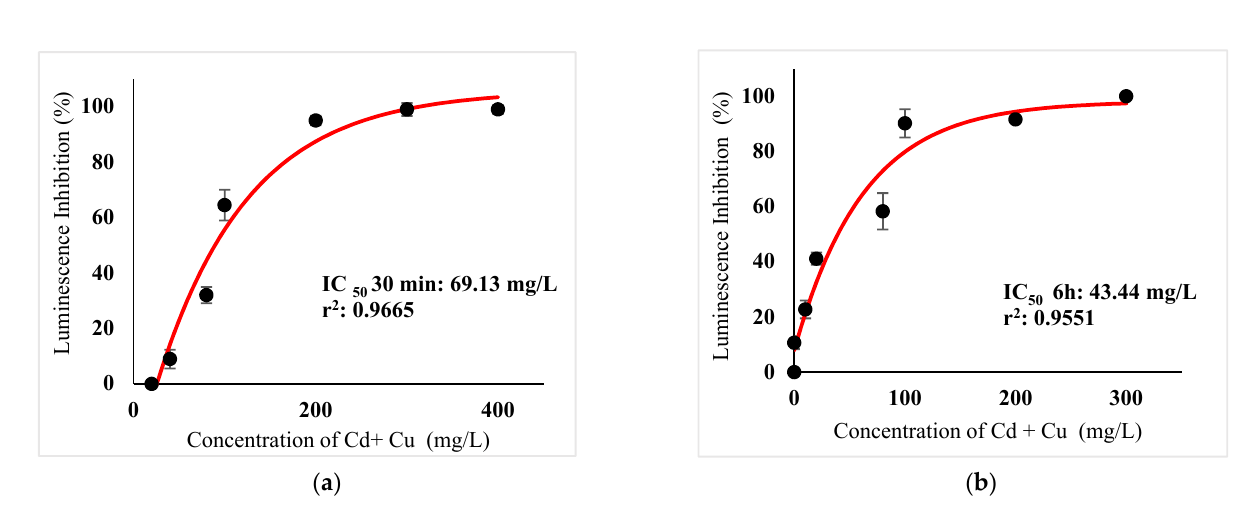
Figure 13. ( a ) Acute and ( b ) Chronic toxicity of mixture Cd 2+ +Cu 2+ in the concentration ratio of 1:1 on luminescence inhibition of Photobacterium sp.NAA-MIE. Data represent mean ± SD, n = 3.